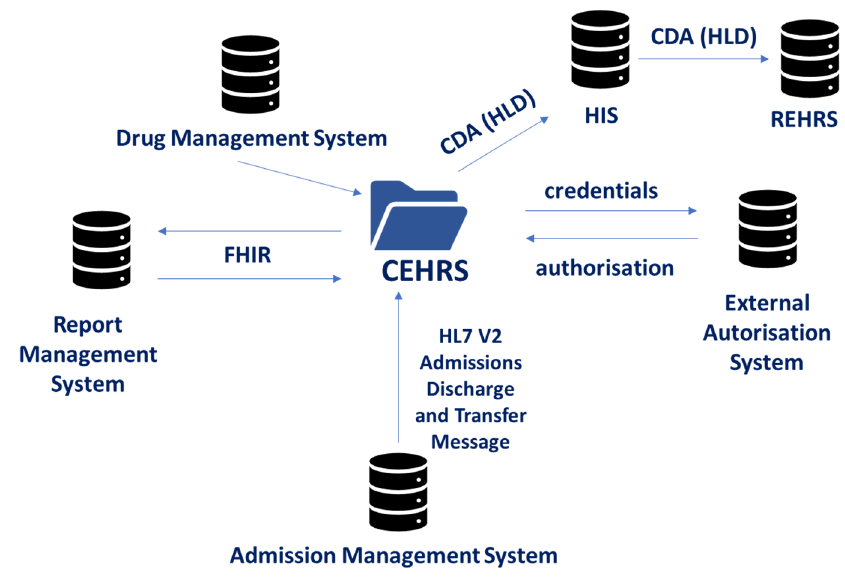
Figure 4. CEHRS Interfaces with other components of the HIS.